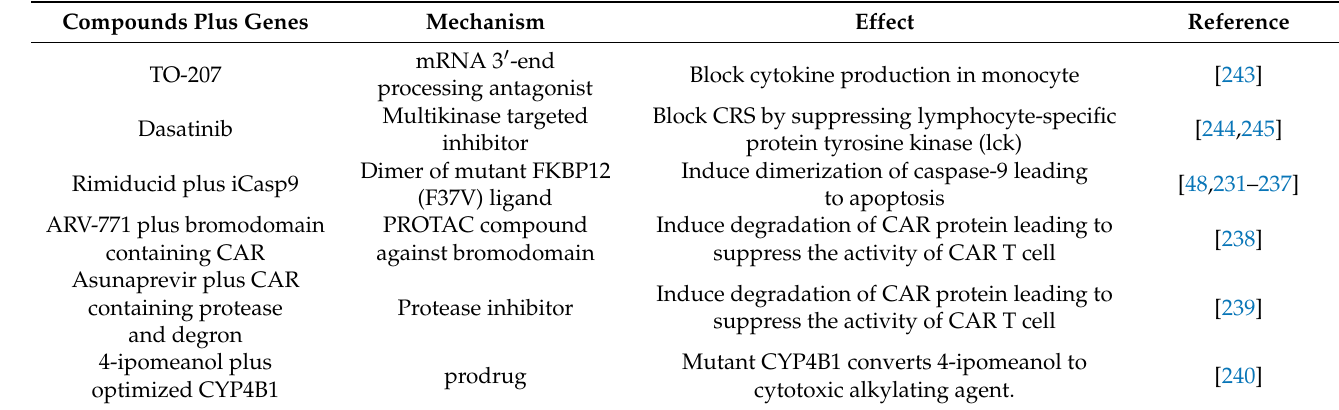
Table 3. Compounds and artificial genes used in safety system for CAR T cell